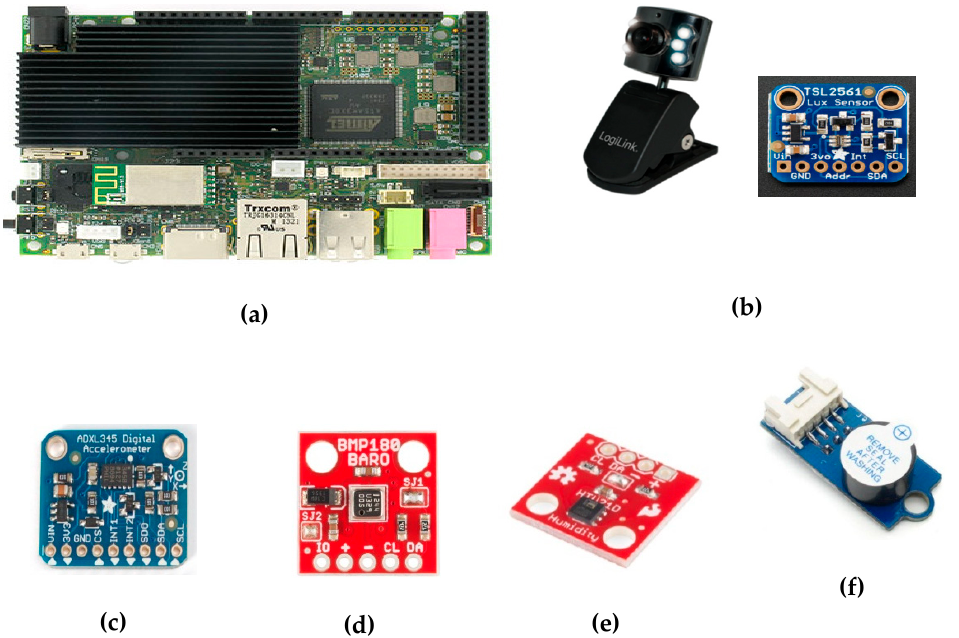
Figure 5. Central processing unit (CPU) board and selected environmental sensors for the prototypical transport box: ( a ) UDOO QUAD board, ( b ) webcam and visible light/infrared sensor, ( c ) digital accelerometer, ( d ) barometric pressure sensor, ( e ) humidity sensor, and ( f ) buzzer.